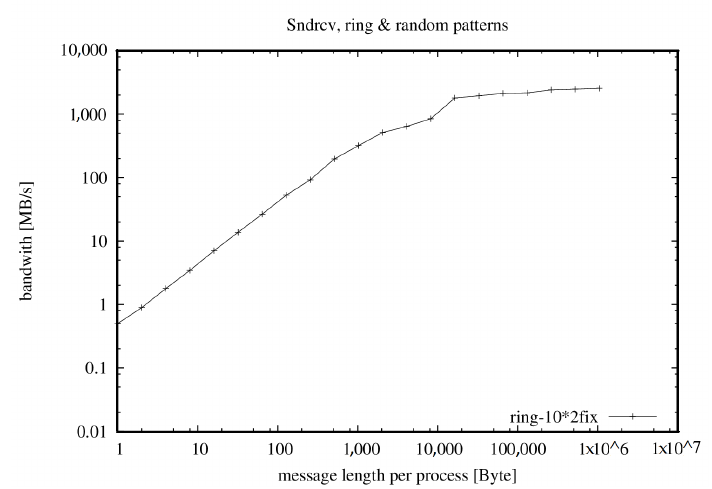
Figure 3. Bandwidth with 20 cores, one per node.